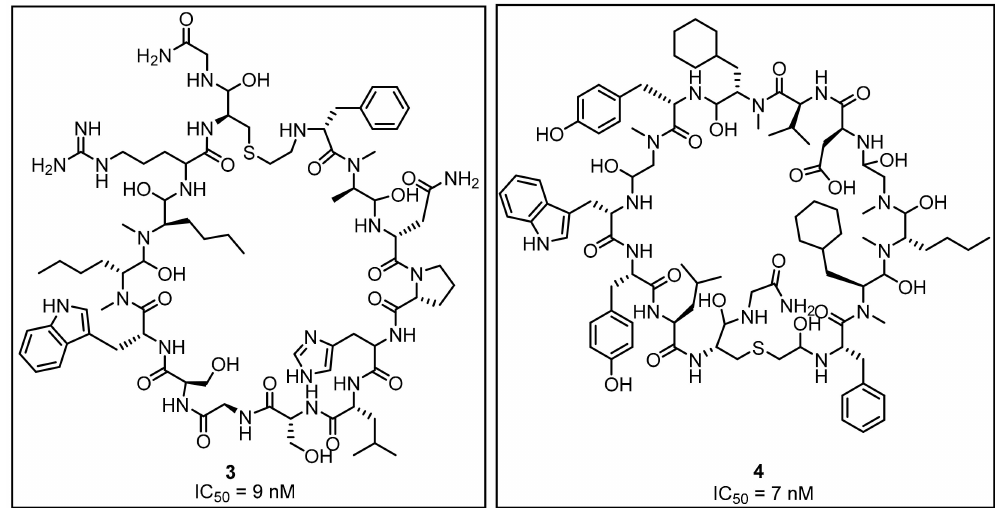
Figure 3. The structures of BMS peptides 3 (BMS-57) and 4 (BMS-71) with their IC 50 values reported in the patent.